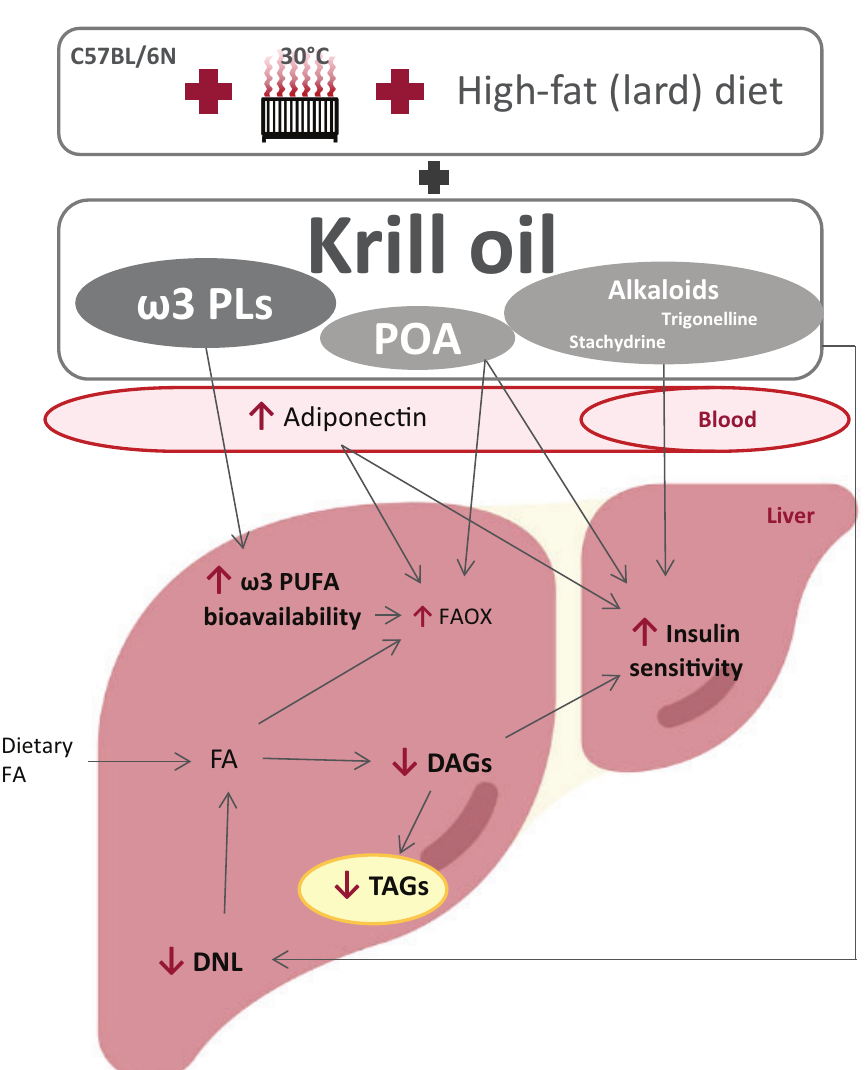
Figure 10. The potential mechanisms involved in the effects of krill oil supplementation on liver fat accumulation and insulin sensitivity in a mouse model of exacerbated hepatic steatosis induced in C57BL/6N mice fed a high-fat (lard) diet in a thermoneutral environment. The effects of krill oil are determined not only by omega-3 PUFA-containing PLs ( ω 3 PLs) in this marine oil, but also by its other bioactive constituents, including palmitoleic acid (POA) and the alkaloids stachydrine and trigonelline, and may involve direct or indirect mechanisms. The livers of mice fed a high-fat diet supplemented with krill oil have markedly reduced TAG accumulation and improved insulin sensitivity, which is associated with increased bioavailability of omega-3 PUFAs, suppressed DNL, decreased tissue DAG levels, and stimulated FA oxidation (FAOX). While many of these changes may be due to indirect mechanisms based on the beneficial effect of krill oil on WAT functionality associated with markedly elevated plasma adiponectin levels, direct mechanisms may include the effect of stachydrine and/or trigonelline, i.e., alkaloids contained in krill oil, which have previously been shown to have positive effects on NAFLD, presumably by restoring hepatic